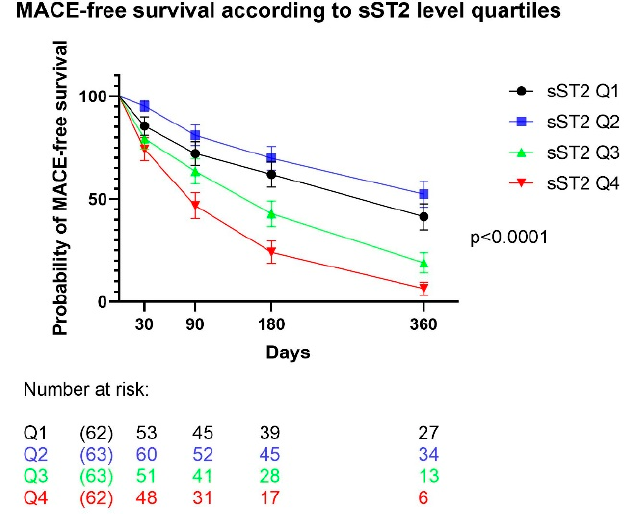
Figure 1. MACE-free survival according to sST2 level quartiles.